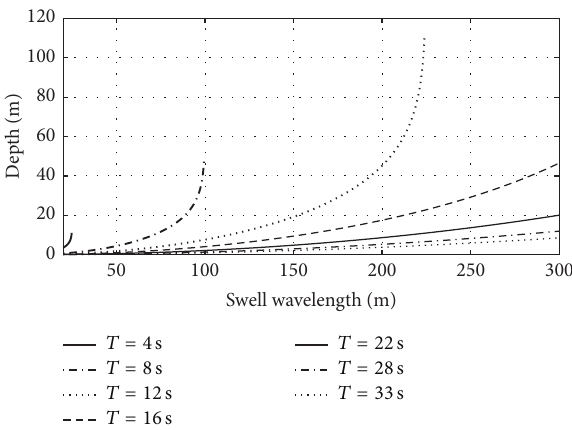
Figure 4: Sea water depth as function of swell period for different values of swell period, 𝑇 , in the range [4; 34] s, according to the linear dispersion relation starting from intermediate water depth up to